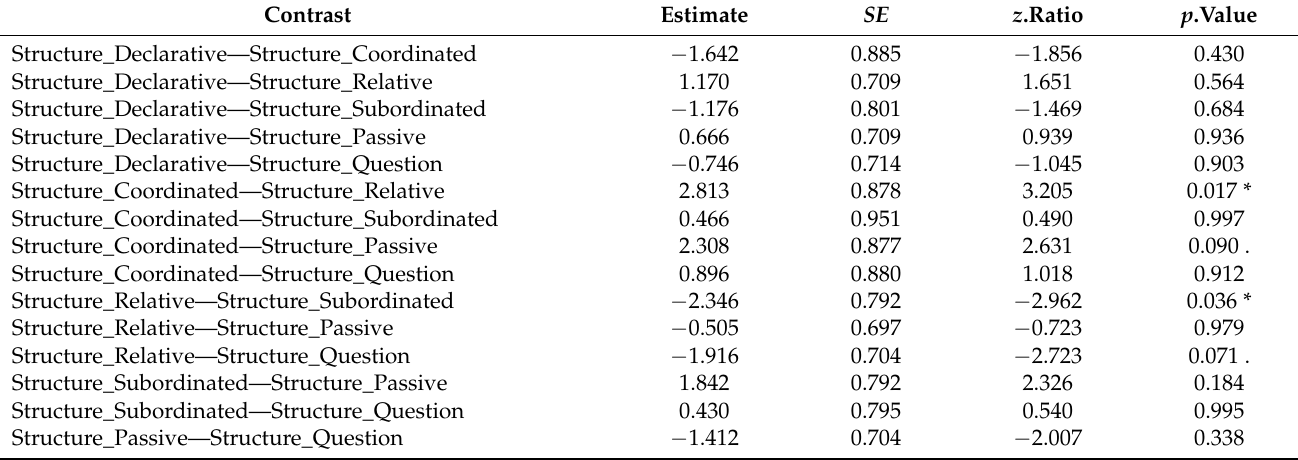
Table A15. Post-hoc tests with a Tukey adjustment showing pairwise contrasts by morphosyntactic structure in English T2 model.